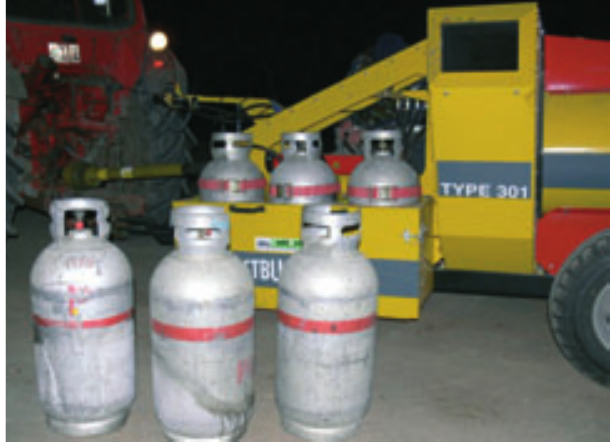
Picture 2 . Replacement of bottles at